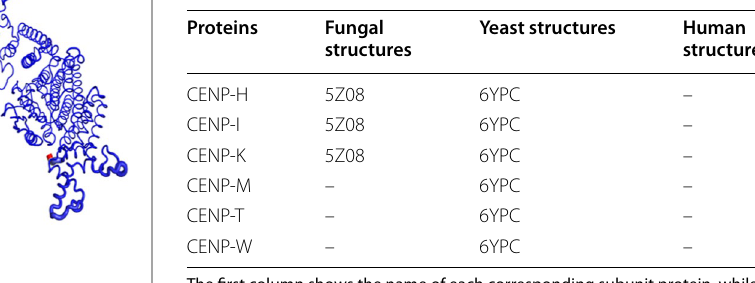
Table 1 PDB codes of existing 3D structures of the CCAN CENP-